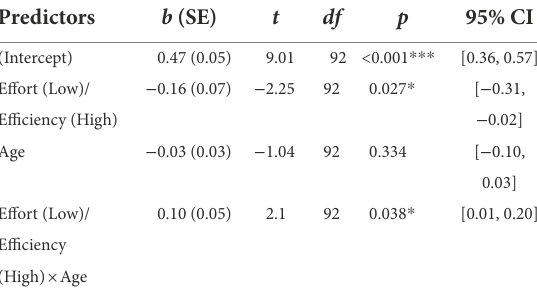
TABLE 2 Fixed effects from the linear mixed-effects model predicting the proportion of gaze to the target AOIs as a function of informant effort/efficiency and child